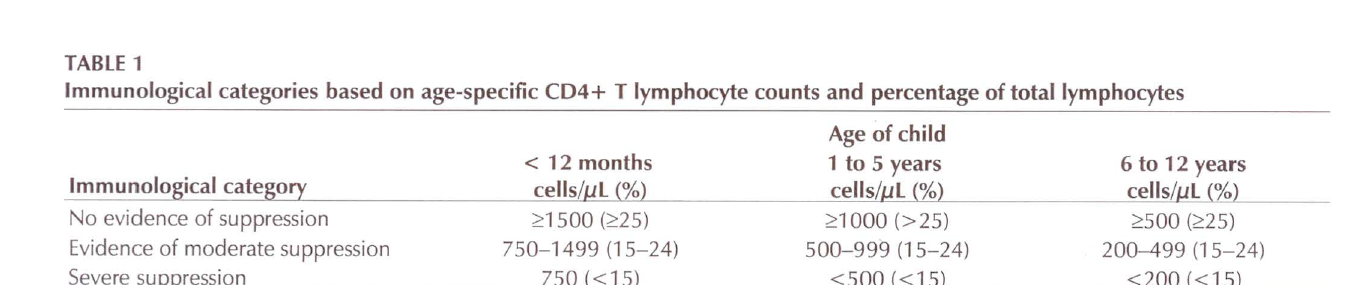
Immunological categories based on age-specific CD4+ T lymphocyte counts and percentage of total